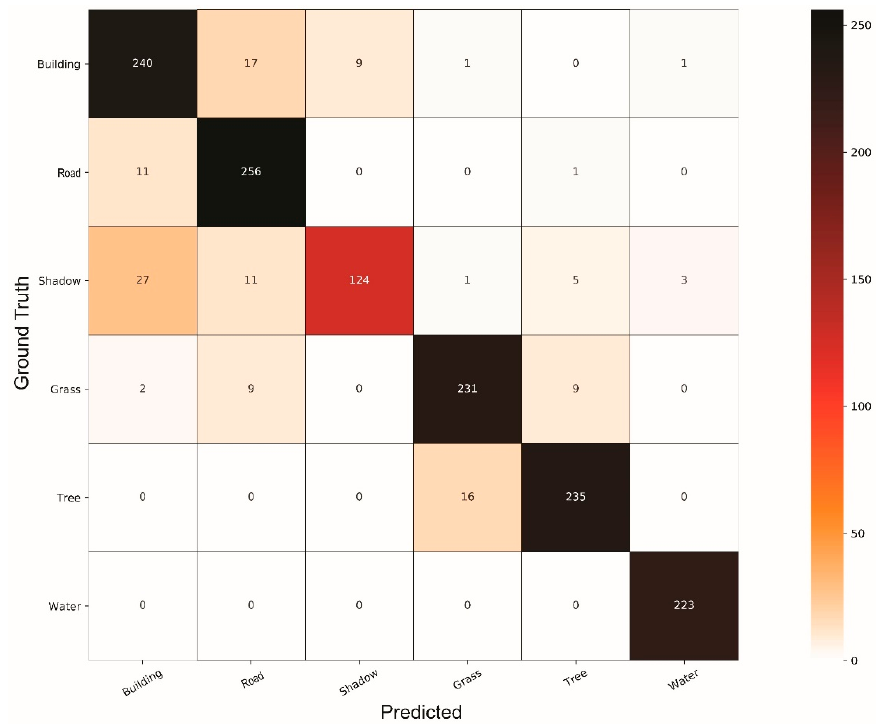
Figure A11. Confusion matrix of the CNN model for 50 cm image.